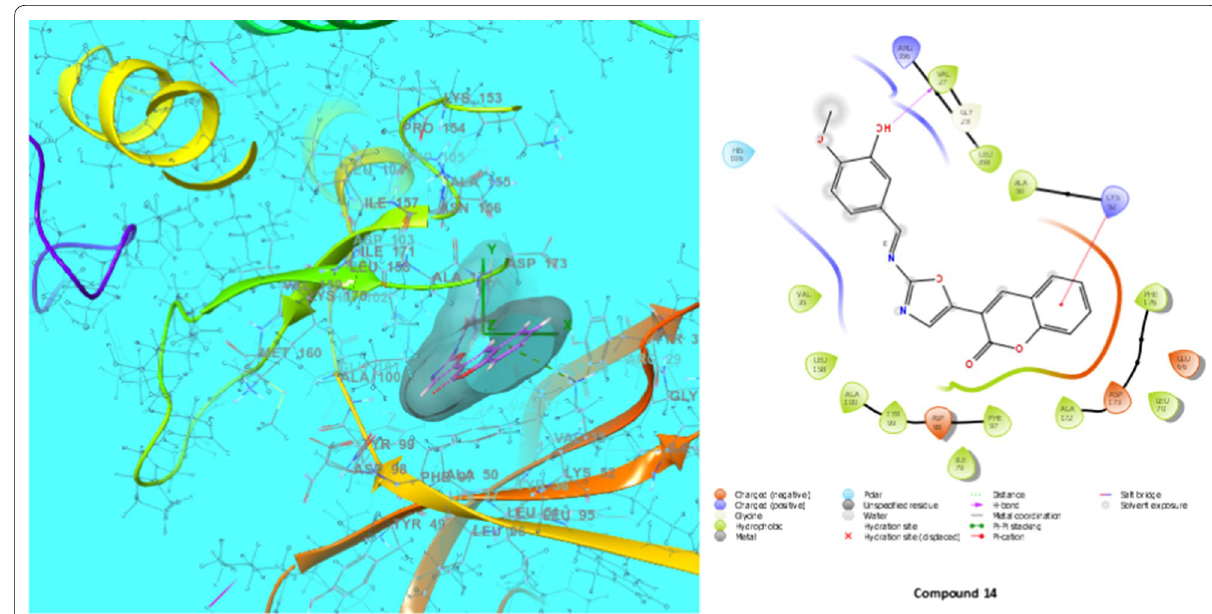
Fig. 6 Interaction of compound 14 and 5-fluorouracil within the active pocket of cdk-8 protein and interacting amino acid in 2D view